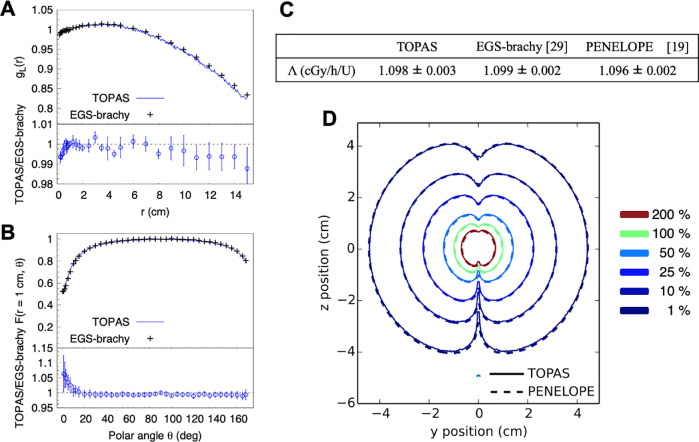
Comparison TOPAS vs. EGS-brachy & Penelope.TG-43 parameters are shown in panels A-C. The geometry function (panel A) and anisotropy function (panel B) are shown with point-to-point ratios, with TOPAS to EGS-brachy, at the bottom of each panel. Displayed errors bars and errors are statistical uncertainties of one standard deviation. In panel C, the dose-rate is shown and compared to EGS-brachy [21] and PENELOPE [20]. Panel D. presents dose distributions normalized at y = 1 cm, z = 0. Continuous iso-dose lines correspond to TOPAS while dashed lines correspond to PENELOPE calculations from Almansa et al [20].